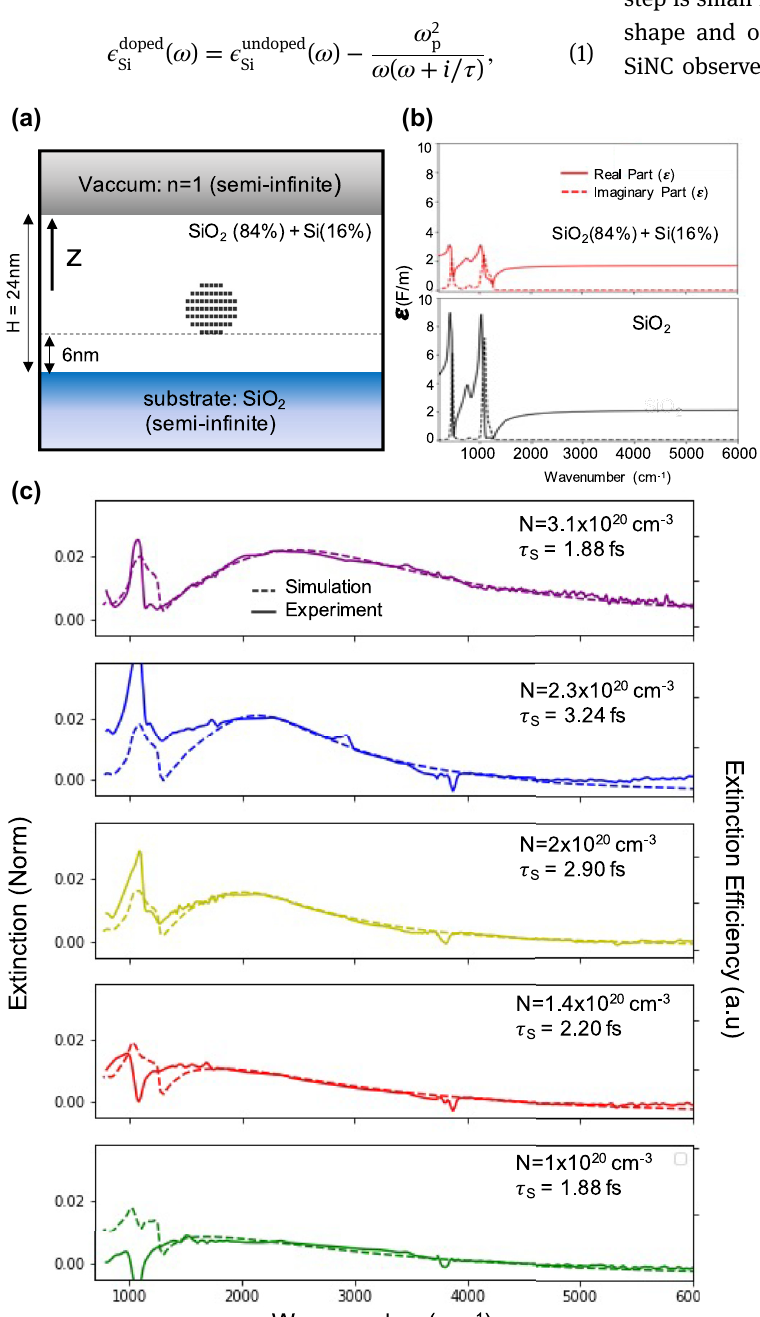
Figure 3: (a) Geometry used in the numerical simulations. The light is propagating along the z direction. (b) Complex dielectric functions used in calculations.Top: calculatedfrom Eq. (2). Bottom: pure silica from [28, 29]. (c) Comparison between simulatednormalizedextinction(dashedline)and experimentalmeasurement(continuousline).The resulting fitting parameters are shown in the top right corner for each P dose (same color code as in Figure